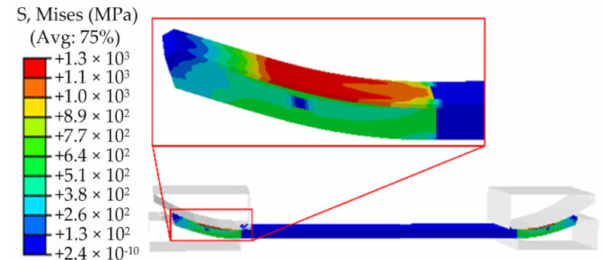
Figure 6. The Mises stress contour of the pre-bending after loading.